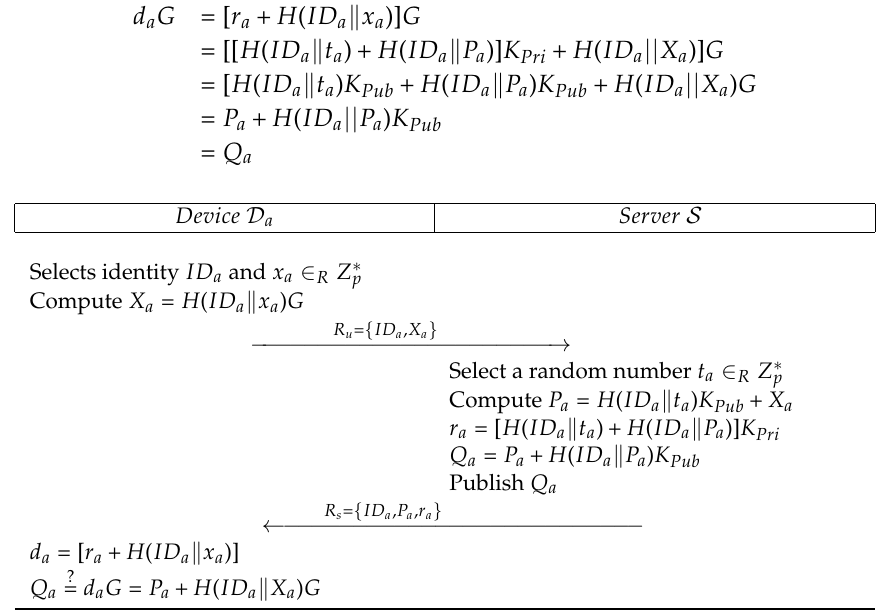
Figure 4. Proposed